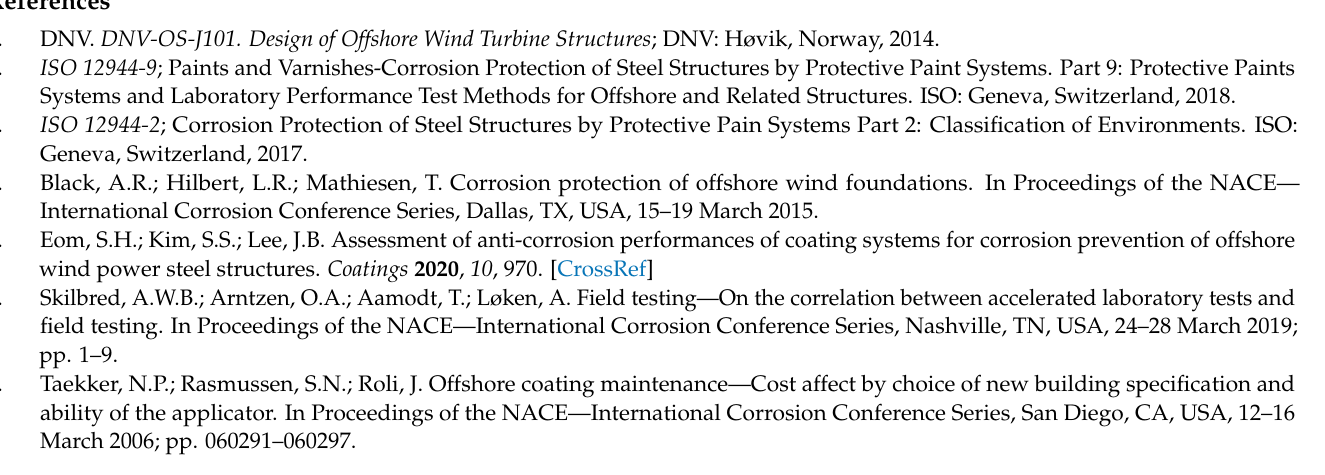
Figure S2: Visual appearance of the splash zone test panels; Figure S3: Visual appearance of the submerged zone test panels; Table S1: Cathodic protection data for splash zone coatings; Table S2: Cathodic protection data for submerged zone